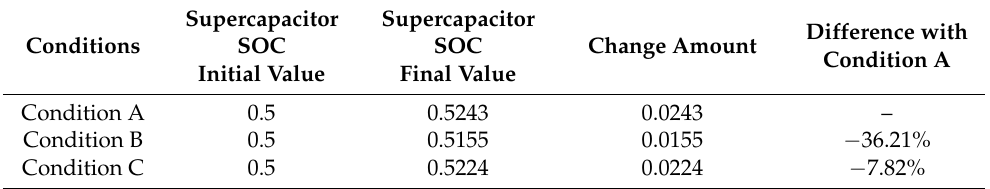
Table 3. Variation in supercapacitor SOC under different